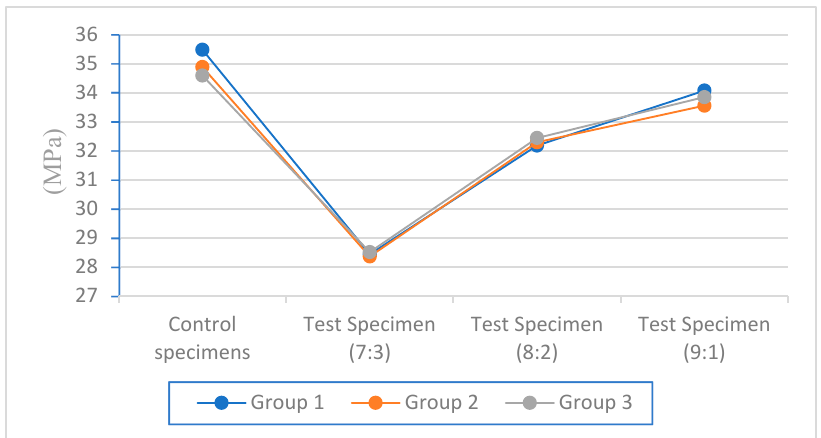
Figure 7. Compressive strength of concrete. Table 5. Strength of specimens (in MPa) with different ratios. Group